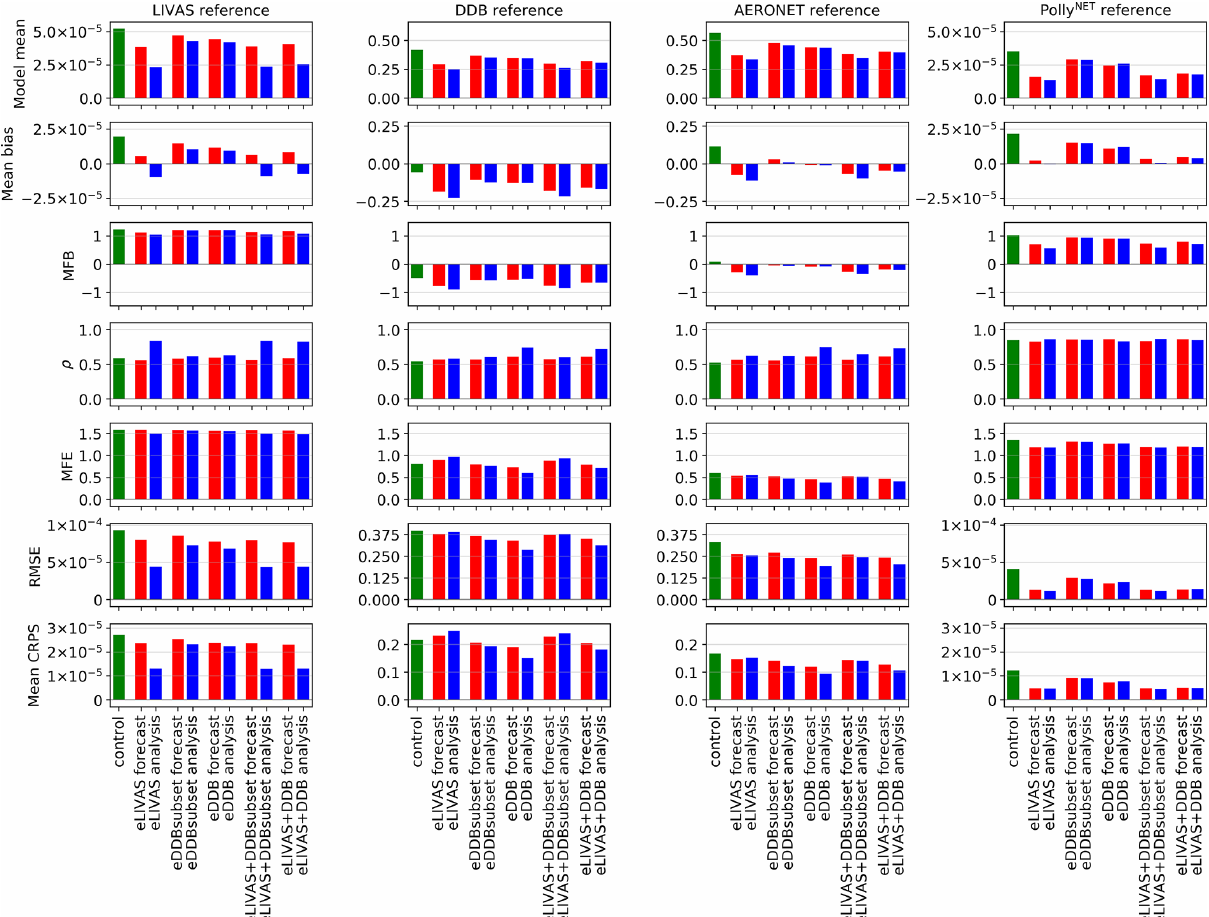
Figure C1. Scores of the full set of five experiments. Similar to Figs. 5, 6, and 8 but with the addition of eDDBsubset and eLI-